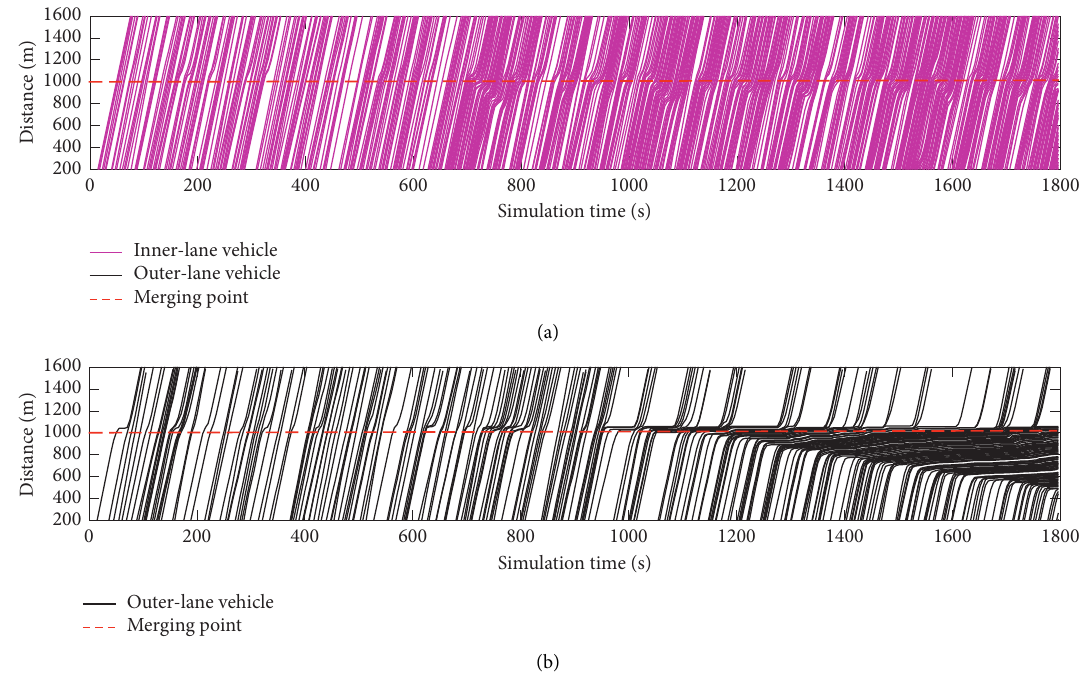
Figure 10: Scenario 0 vehicle trajectories. (a) Inner-lane vehicle trajectories. (b) Outer-lane vehicle trajectories.